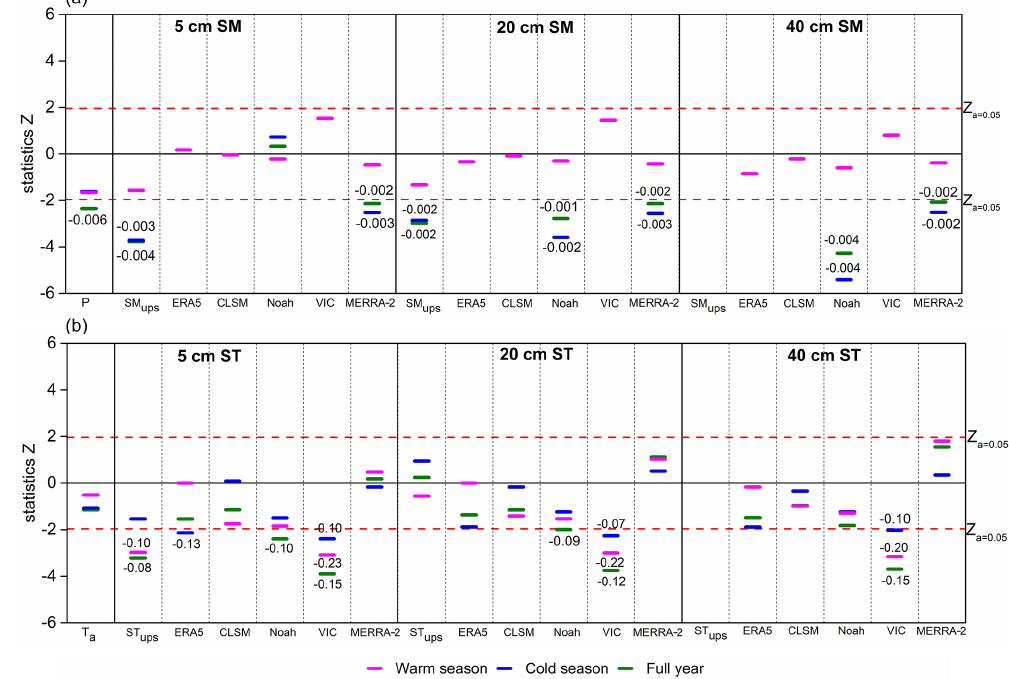
Figure 6. Mann–Kendall trend test and Sen’s slope estimate for the long-term (a) SM and (b) ST at depths of 5, 20, and 40cm from 2010 to 2018 as obtained from the upscaled dataset and different model-based products for the Maqu network. The trend analysis results for the precipitation and air temperature are also shown in panels (a) and (b) , respectively. The digits in the figure represent the values of the Sen’s slope estimate.